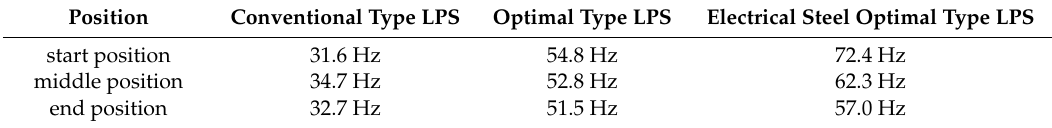
Table 2. Cutoff frequency of the three types of the LPS at different position in the working stroke. Table 2. Cuto ff frequency of the three types of the LPS at di ff erent position in the working stroke. Conventional Optimal Electrical Steel Position Position Conventional Type LPS Optimal Type LPS Electrical Steel Optimal Type LPS Type LPS Type LPS Optimal Type LPS